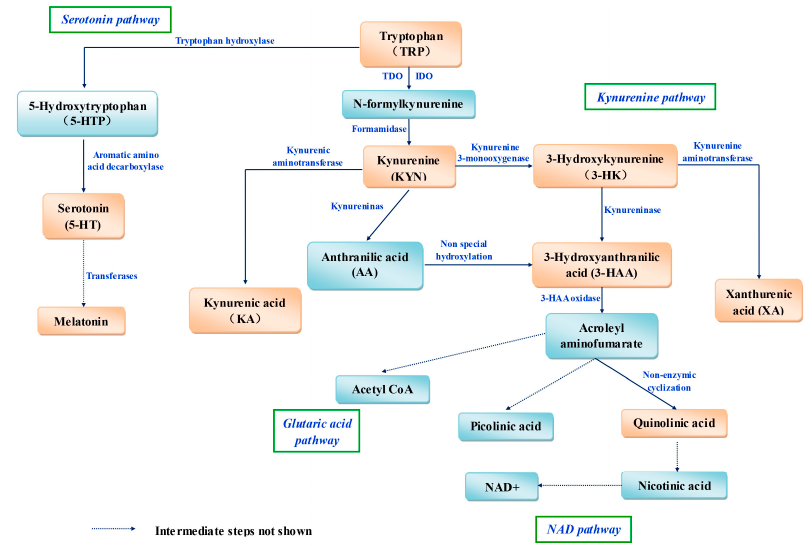
Figure 1. Schematic diagram of tryptophan metabolism in mammals. Several intermediate metabolites and enzymes are shown; Some metabolites with redox properties are in orangered frames. NAD, nicotinamide adenine dinucleotide; NAD + , oxidized form of nicotinamide adenine dinucleotide; Acetyl CoA, acetyl coenzyme A.